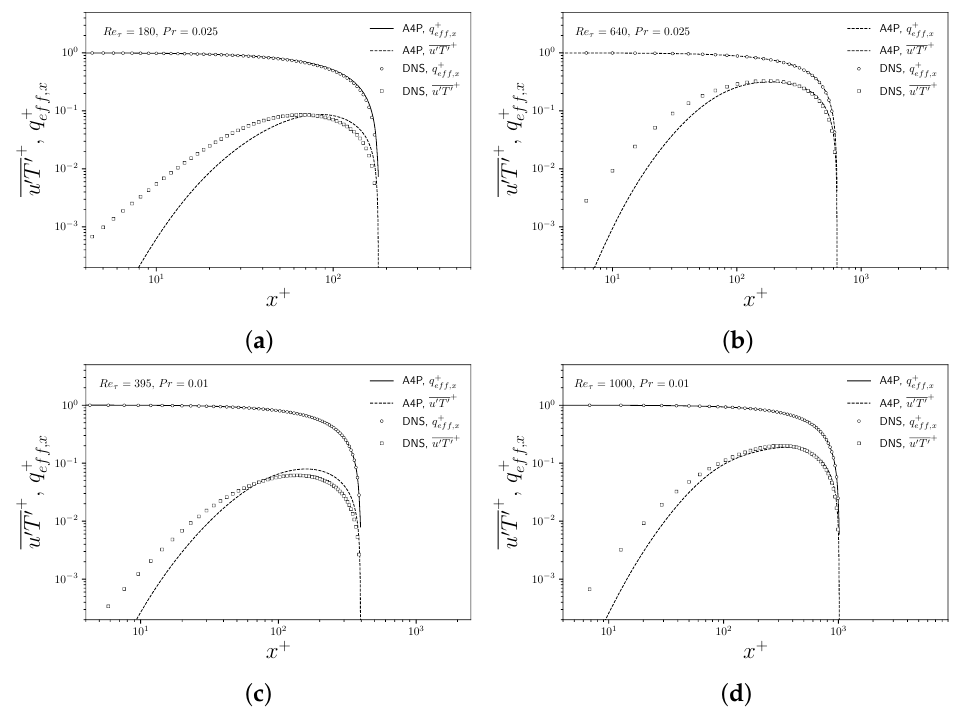
Figure 5. Non-dimensional normal total heat flux q + and non-dimensional normal component of the ef f + turbulent heat flux u (cid:48) T (cid:48) for Re τ = 180 Pr = 0.025 ( a ), Re τ = 640 Pr = 0.025 ( b ), Re τ = 395 Pr = 0.01 ( c ), and Re τ = 1000 Pr = 0.01 ( d ). DNS data from [17] for Pr = 0.025 and [19,20] for Pr =